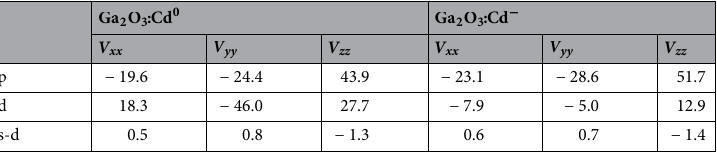
2 α − 1 for α = 0.118 (the